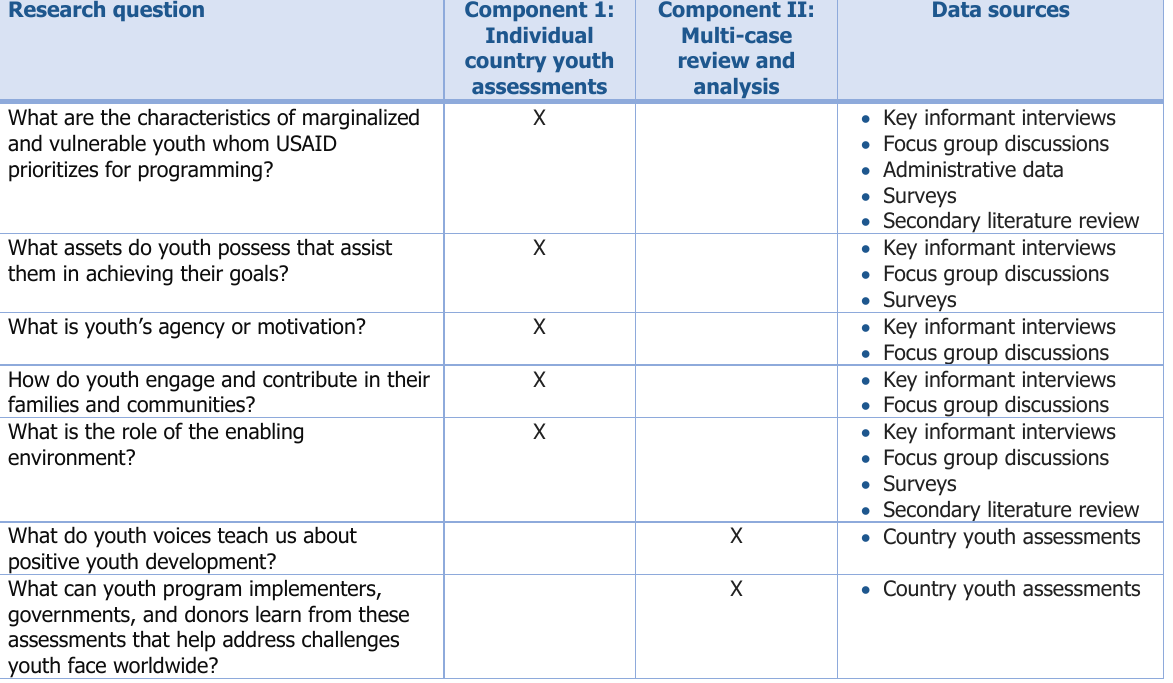
Table 1 summarizes the two main components of data collection used for this study. Table 1. Study Components, Research Questions, and Data Sources Research